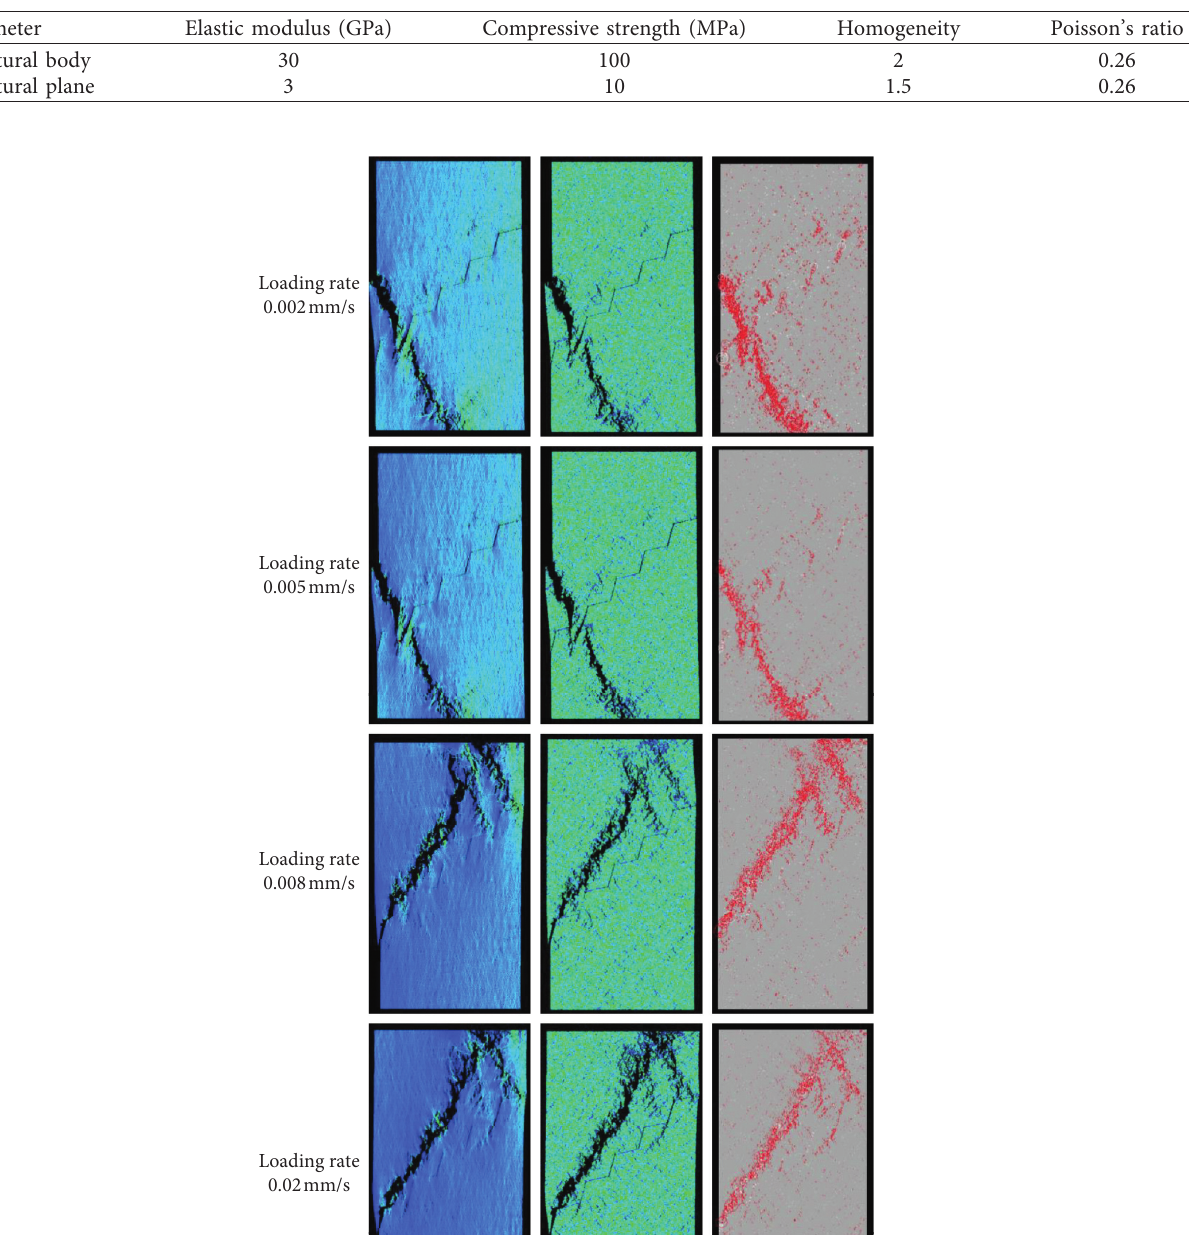
Table 1: Numerical specimen